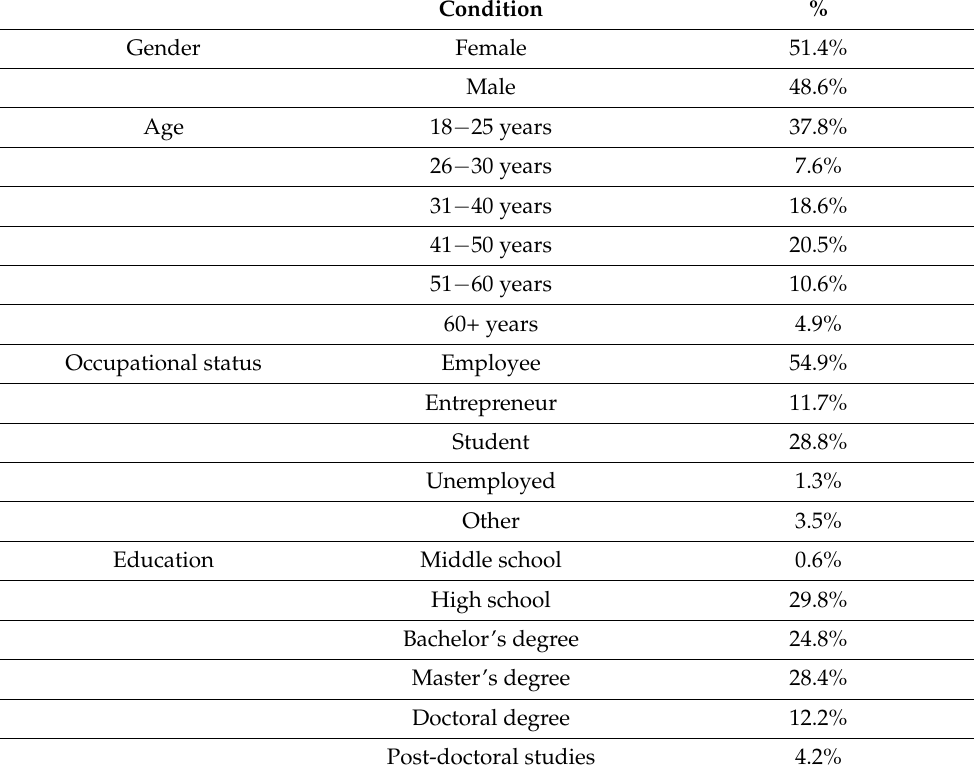
Table 1. Socio-demographic characteristics of the